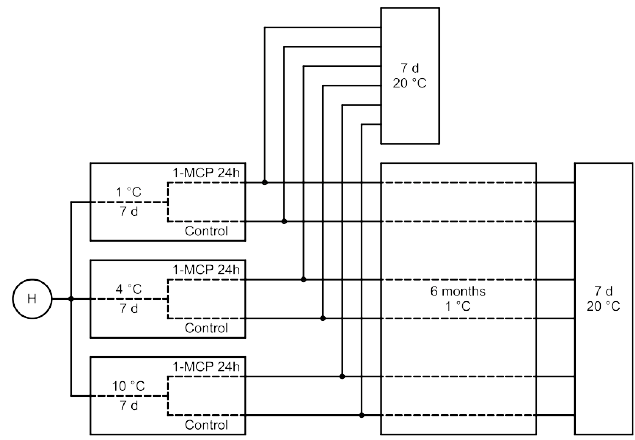
Fig. 1: Experimental plan from harvest (H) with 7 d precooling, 6 months storage and 7 d shelf-life. Steps are simulating: short-term storage in orchard and transportation (7 d, 1-10 °C); long-term storage (6 months, 1 °C); storage in shop and household (7 d, 20 °C). The gaseous 1-MCP treatment was performed with commercial tab- lets (0.14% 1-MCP) as an application of the SmartFresh® system, provided by Rohm and Haas Polska Sp.z.o.o. (Warsaw,